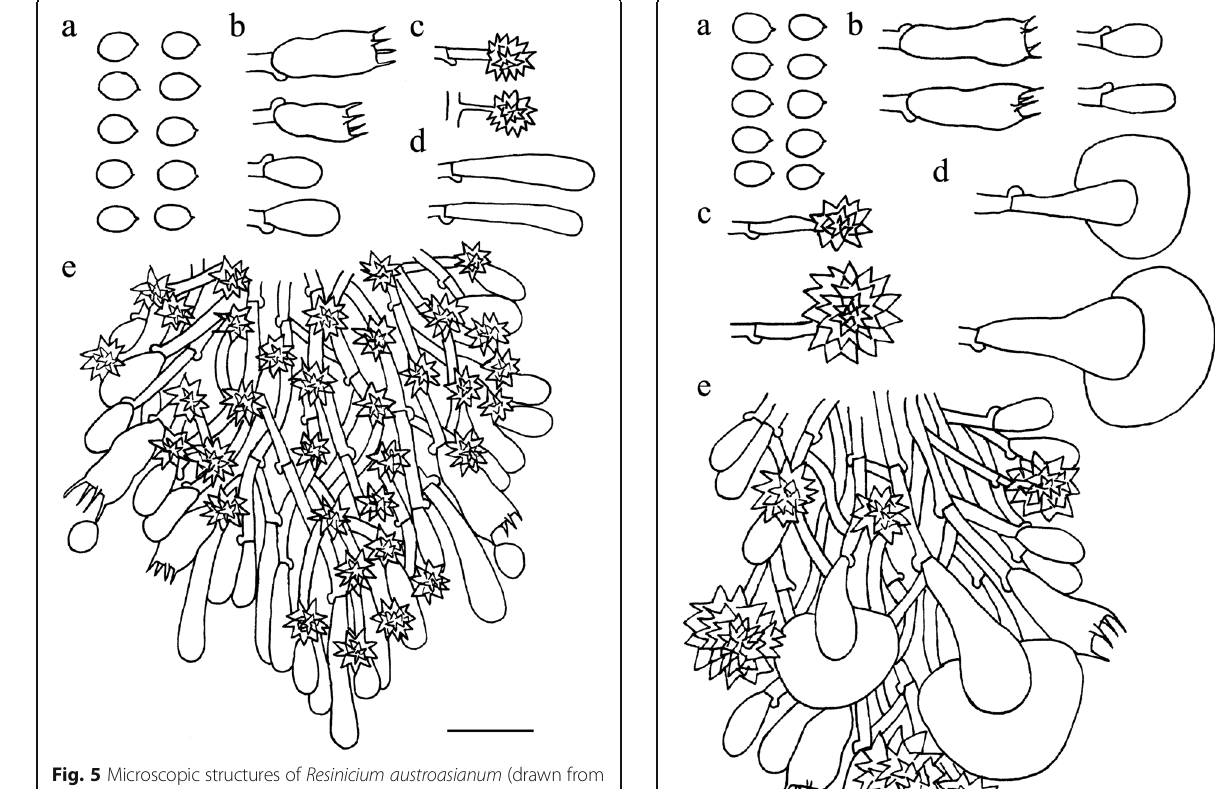
3 – 4 per mm, 300 – 500 μ m long. Subiculum not stratified, straw-yellow to olivaceous buff, 100 – 200 μ m thick. Mar- gin gradually thinning out, white, occasionally with my- celia cords.